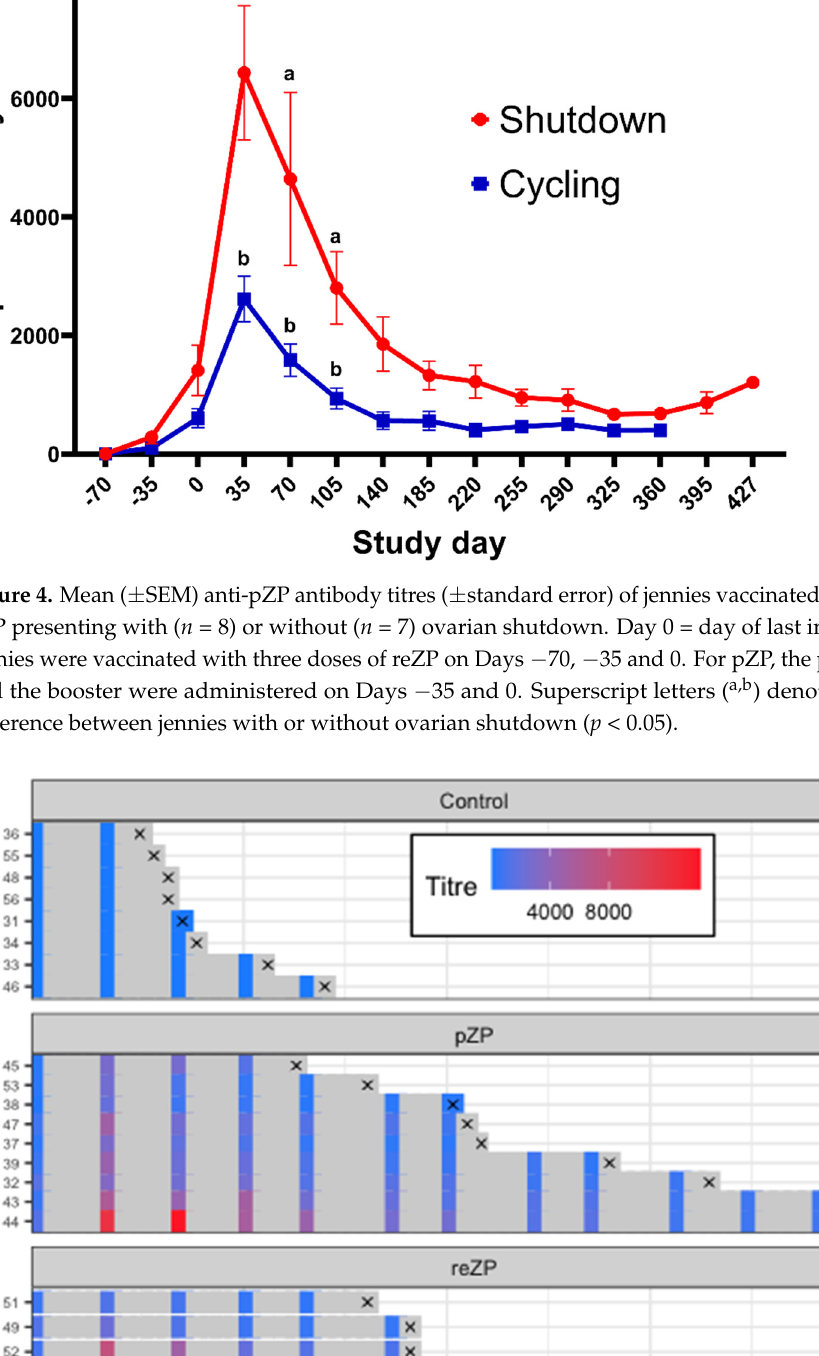
doses of reZP on Days − 70, − 35 and 0. For both pZP and Control, the primary dose and the booster were administered on Days − 35 and 0. Superscript letter ( a ) denote difference between reZP and Control group, wheres asterisk (*) denotes differences between both treated groups (reZP and pZP) and the Control group ( p < 0.05).